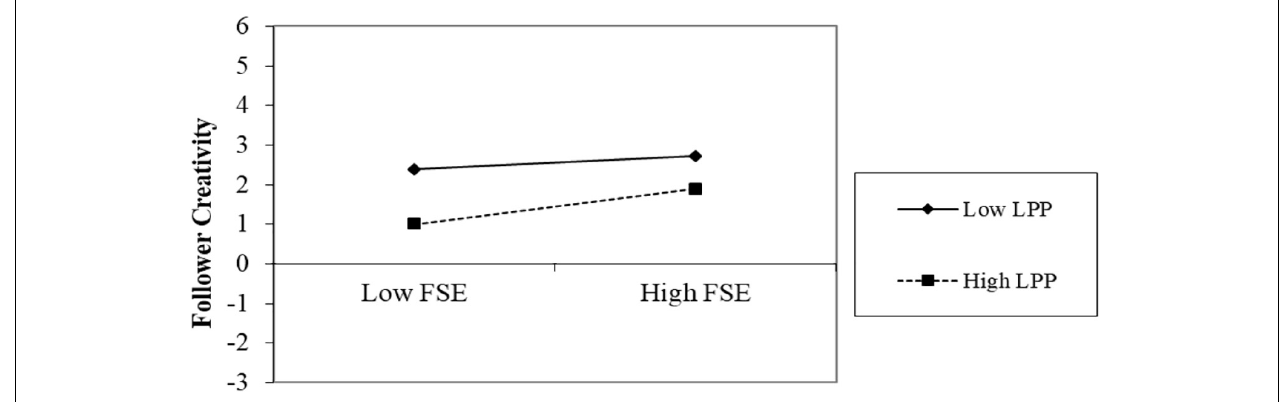
FIGURE 2 | Moderation effect of leader proactive